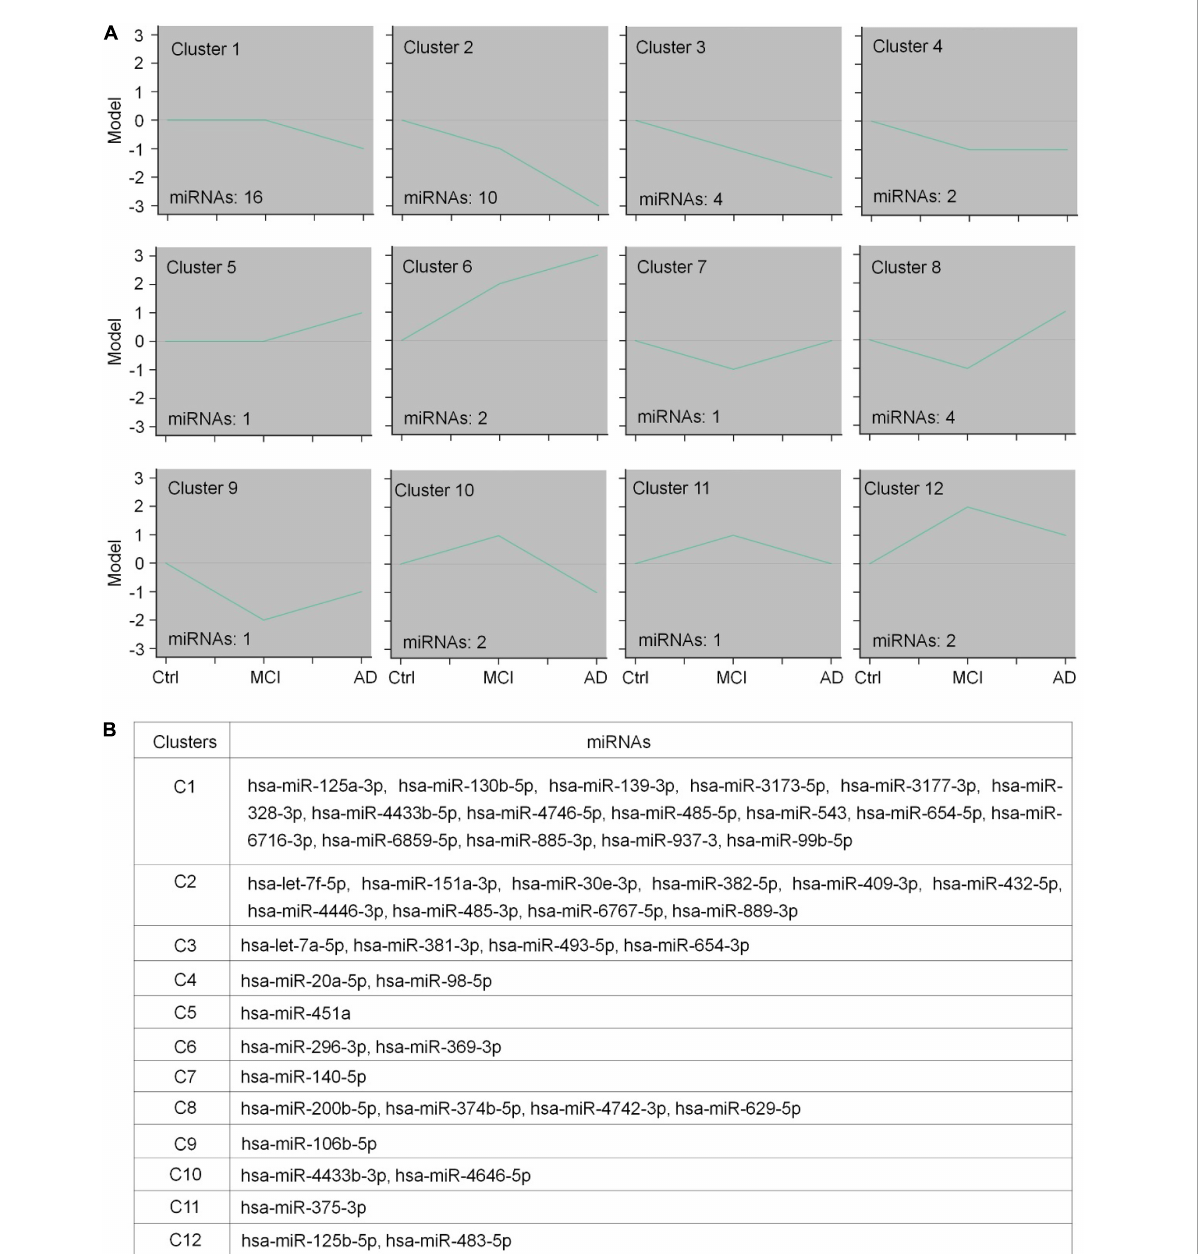
FIGURE2 The expression patterns of differentially expressed circulating EV-containing miRNAs (DECEmiRs). (A) The expression profiles of DECEmiRs during AD progression were classified into 12 clusters using a mathematical fuzzy clustering strategy by STEM software. The green lines in the square indicate the overall gene expression trends. The number on the upper left of the small square indicates the cluster number; the number on the lower left of the small square indicates the DECEmiR number. Y-axis refers to relative expression levels of miRNAs, and X-axis indicates the stages of AD (controls, MCI, and AD). (B) Member DECEmiRs in the identified STEM clusters.